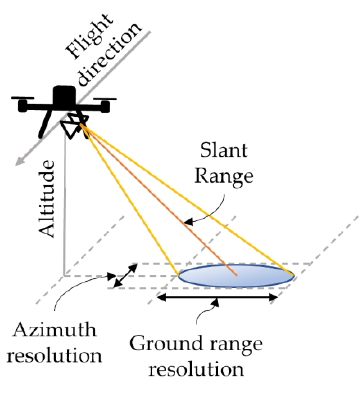
Figure 6. Radar imaging principle.